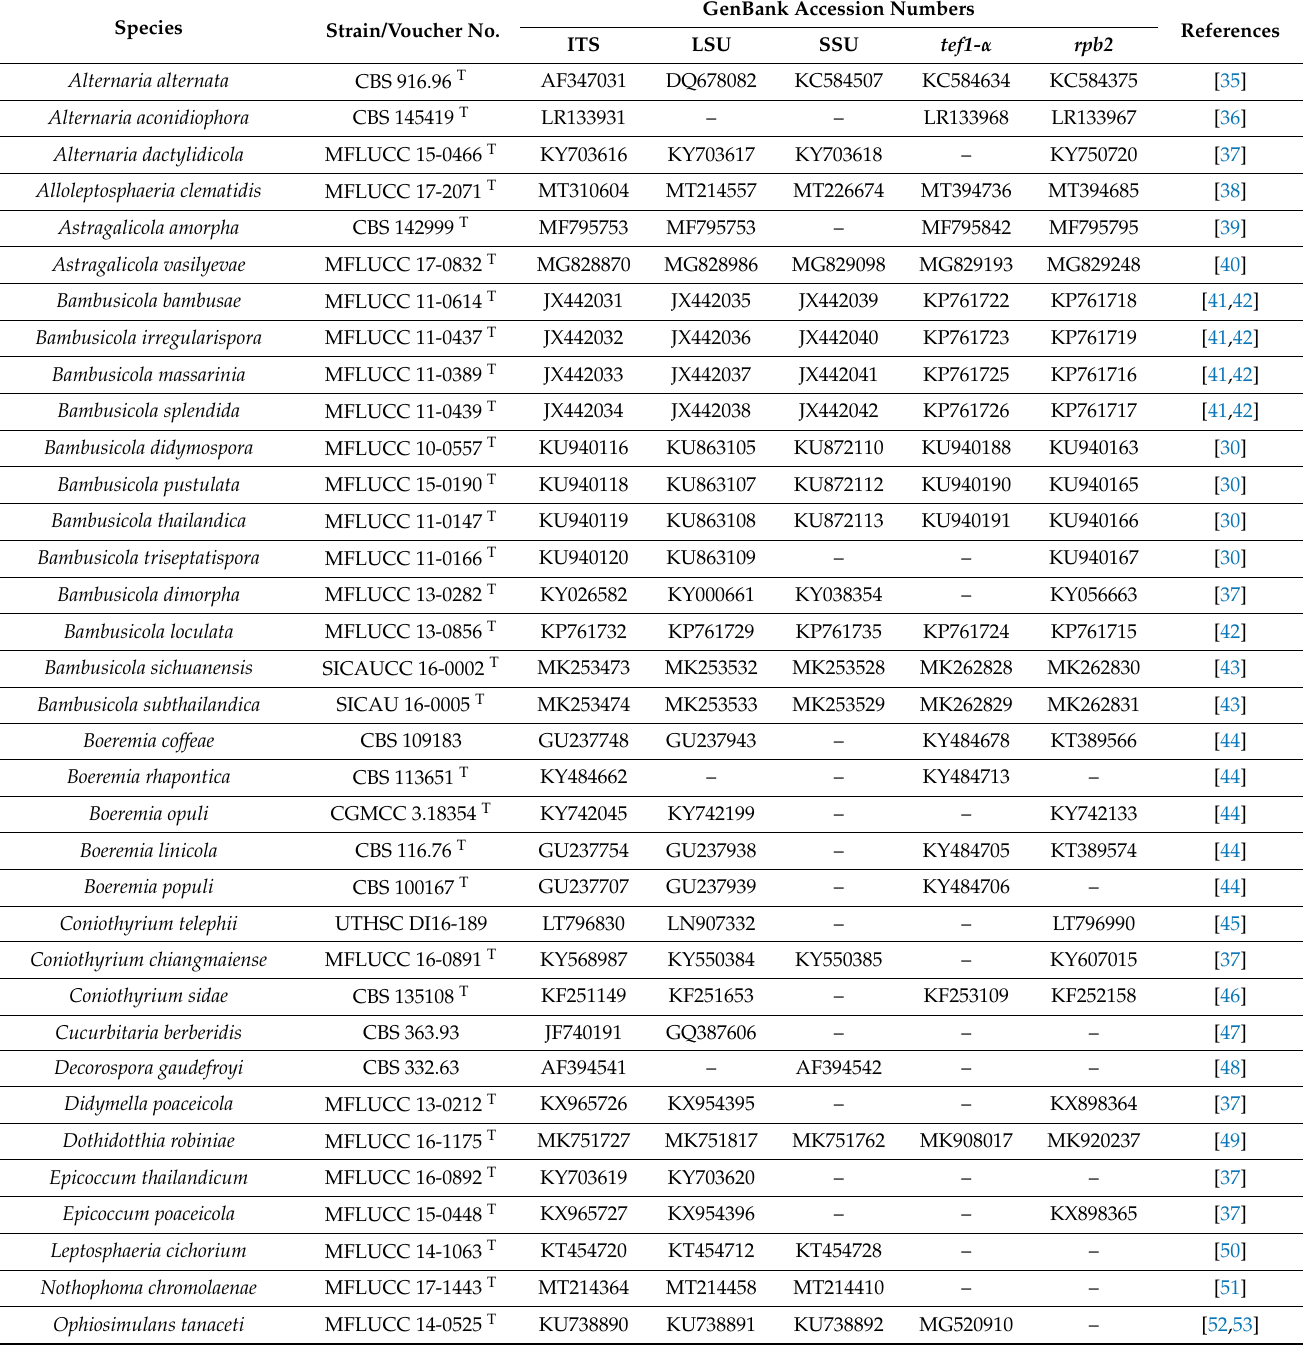
Table 1. GenBank accession numbers of strains in Pleosporales and Tubeufiales used for the phylogenetic analyses of Podonectria .